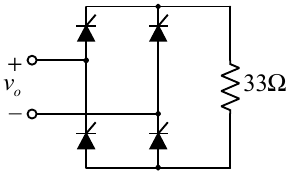
Figure 10. Configuration of the load used in the simulation and the experiments.